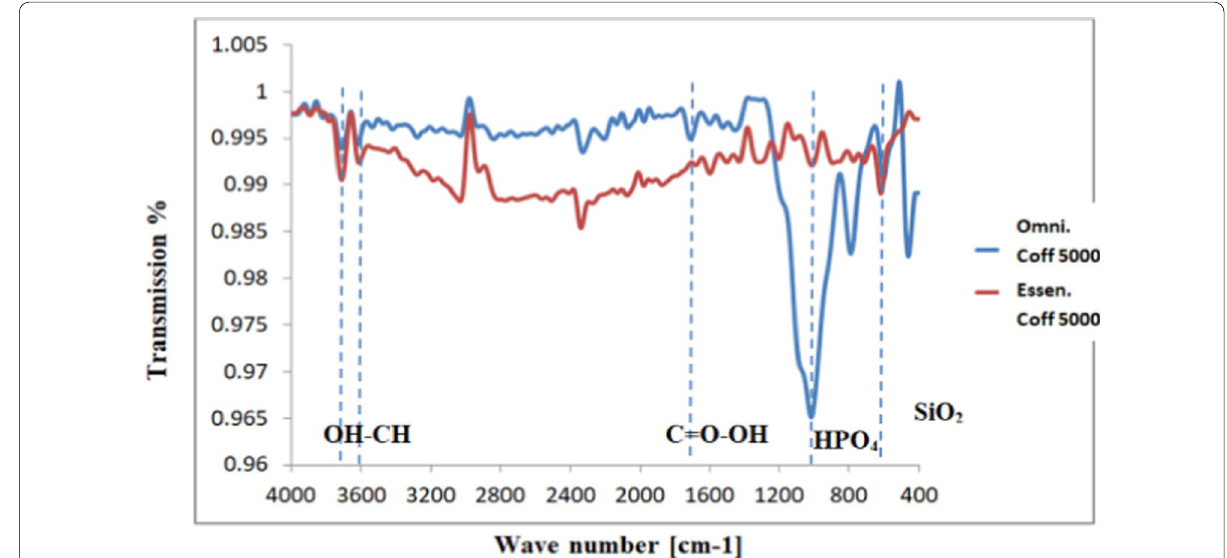
Fig. 9 FTIR spectra representing the chemical structure of Omnichroma Coff 5000 and Essentia Coff 5000